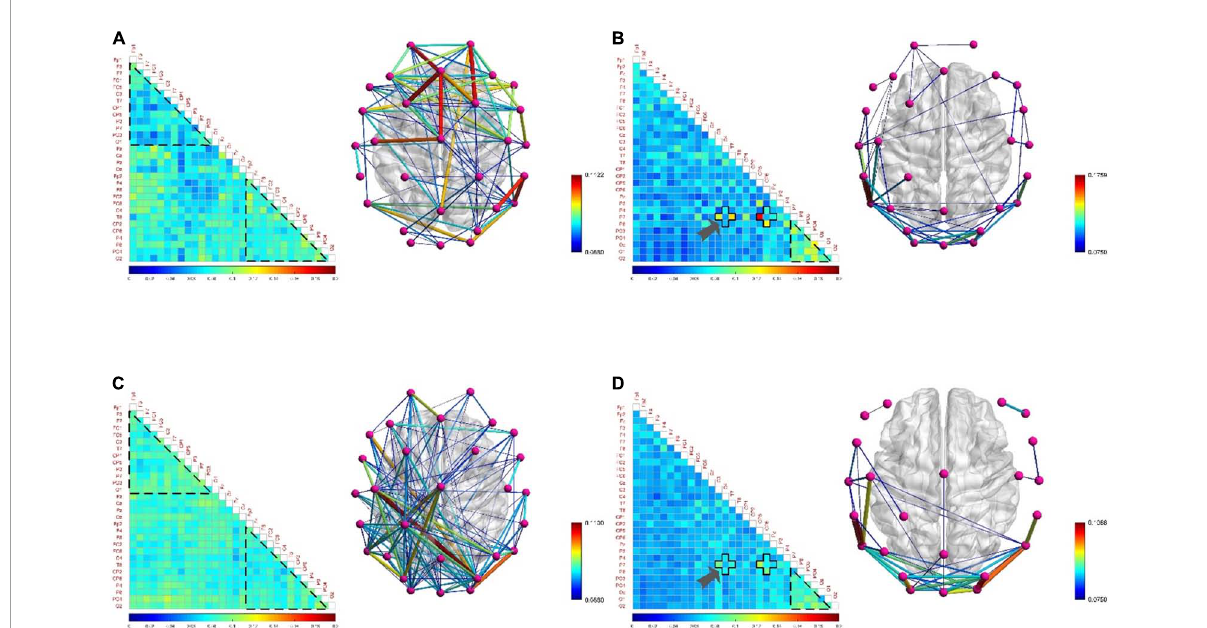
FIGURE11 The functional brain networks and connectivity matrices in positive and negative states. (A) The situation when the electroencephalogram (EEG) is at low frequency in the positive state. In order to observe the difference between the left and right hemispheres from the matrix diagram, the channels in the matrix diagram are arranged in the order of left hemisphere, central axis, and right hemisphere from top to bottom, and other settings are the same as before. (B) The situation when the EEG is at high frequency in the positive state. (C) The situation when the EEG is at low frequency in the negative state. The channels in the matrix diagram are arranged in the order of left hemisphere, central axis, and right hemisphere from top to bottom, and other settings are the same as before. (D) The situation when the EEG is at high frequency in the negative